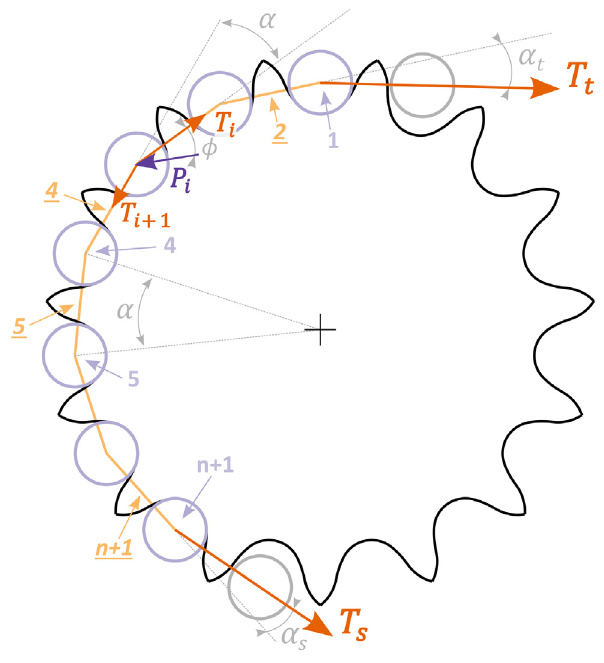
Fig. 12. Roller and link